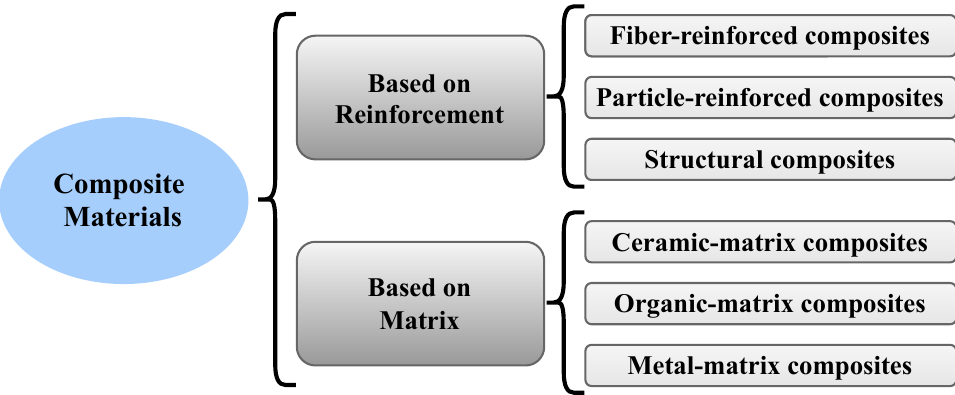
Figure 2. The classification of the composite